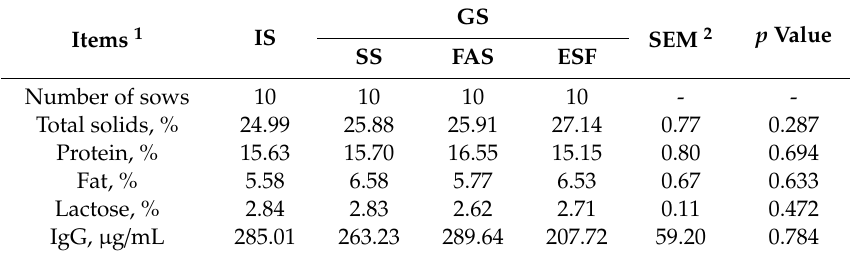
Table 5. E ff ects of individual stalls (IS) and group housing systems (GS) on colostrum composition of sows. GS Items 1 IS SEM 2 p Value SS FAS ESF Number of sows 10 10 10 10 - - Total solids, % 24.99 25.88 25.91 27.14 0.77 0.287 Protein, % 15.63 15.70 16.55 15.15 0.80 0.694 Fat, % 5.58 6.58 5.77 6.53 0.67 0.633 Lactose, % 2.84 2.83 2.62 2.71 0.11 0.472 IgG, µ g / mL 285.01 263.23 289.64 207.72 59.20